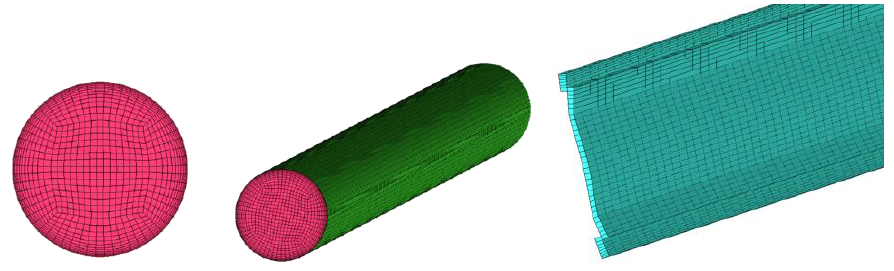
Figure 2. Schematic diagram of the grid.